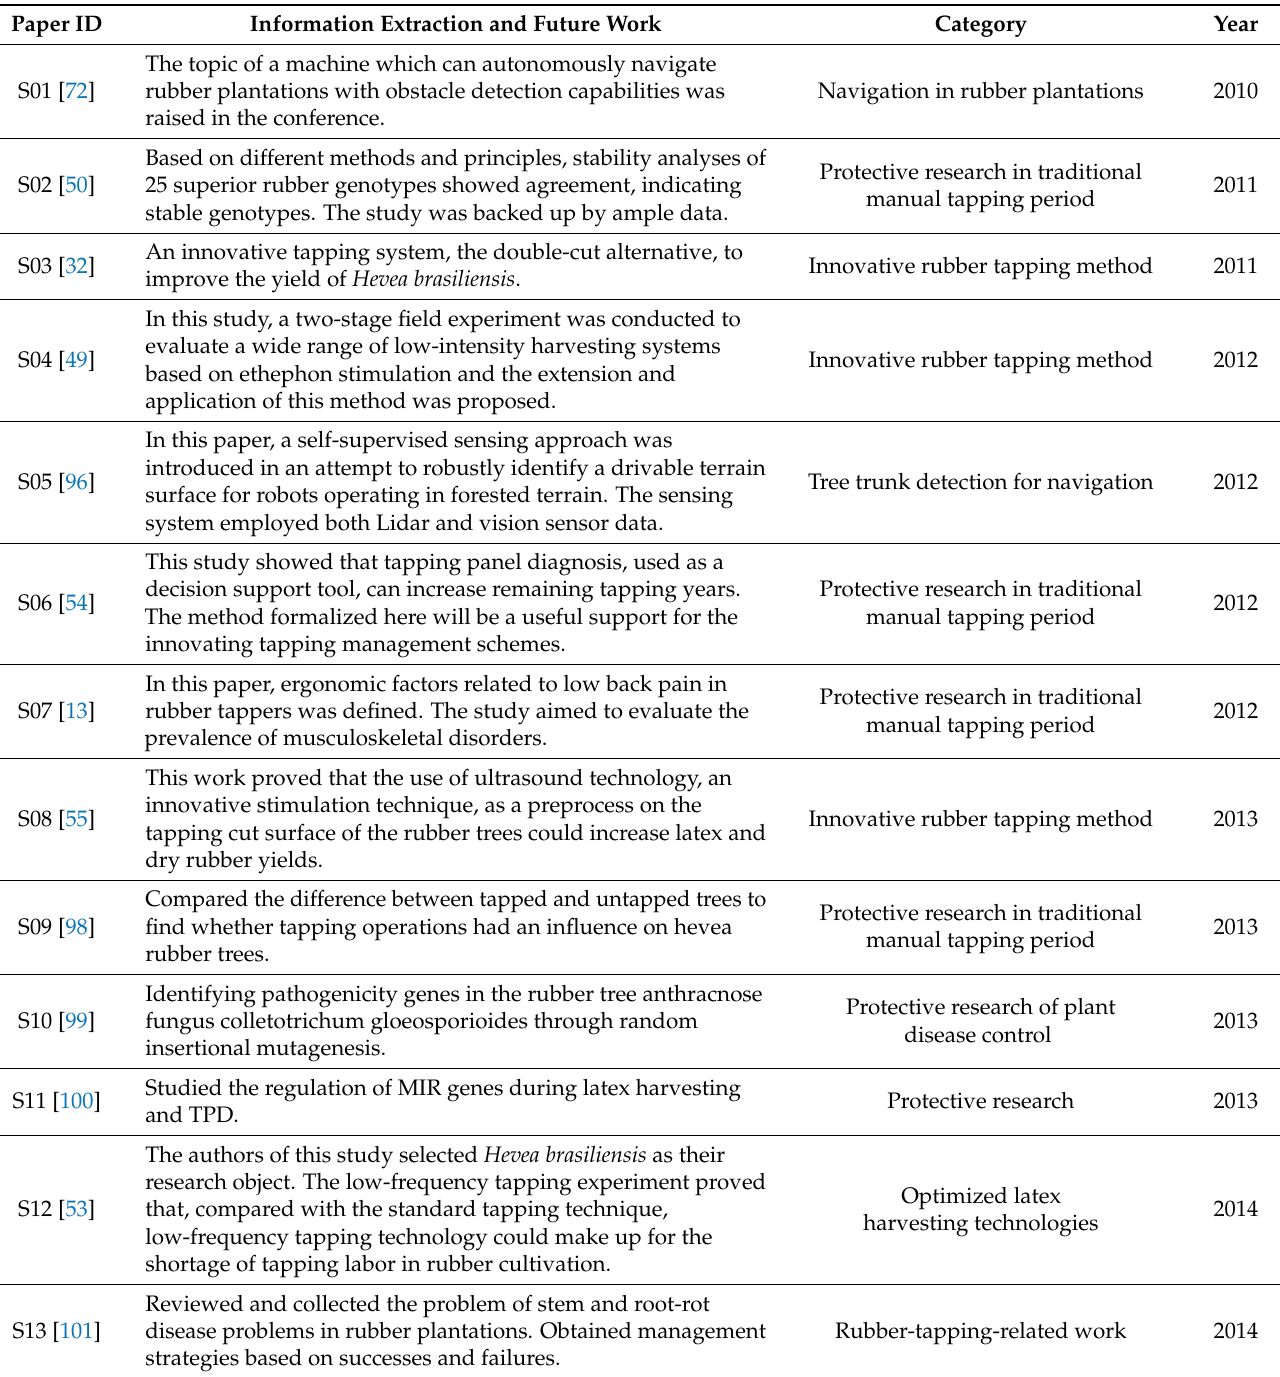
Table A1. A summary of the 50 articles included after the final selection